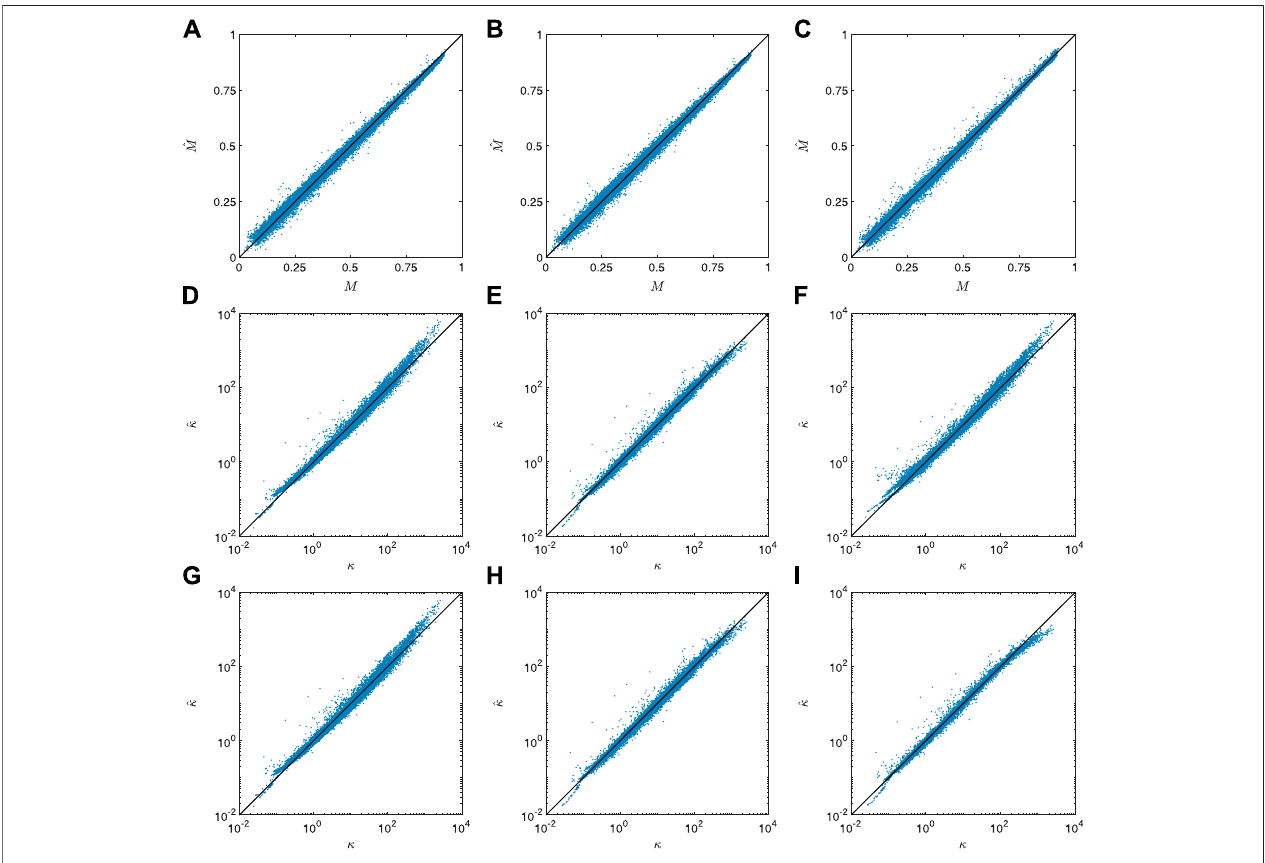
FIGURE 3 | Prediction of effective transport properties using analytical formulas. Top row (from left to right): Prediction of M-factor via Eqs. 10 – 12 . Middle row (from left to right): Prediction of permeability via Eqs. 13 – 15 . Bottom row (from left to right): Prediction of permeability via Eqs. 16 – 18 . Note that the scatter plots show results based on the test